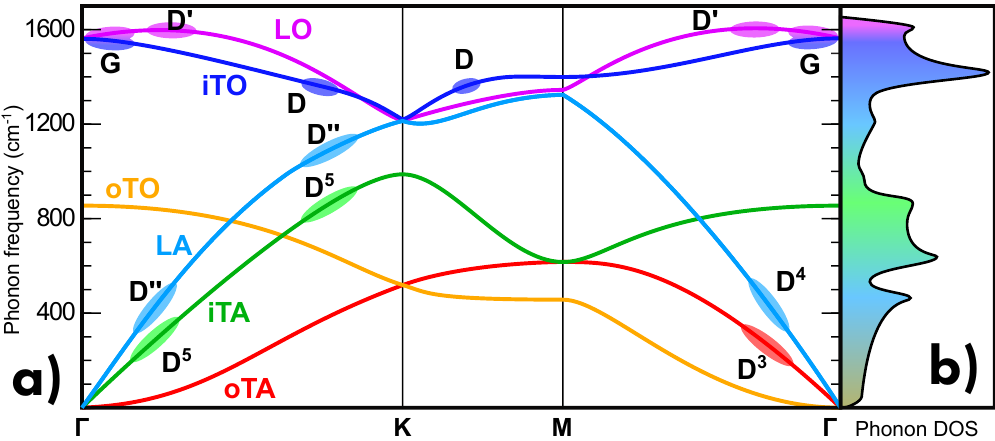
Figure 14. ( a ) Phonon dispersion relation for graphene along the direction connecting the high-symmetry points Γ , K , and M . The phonon branches are labeled in accordance with their type of atomic displacement. Various Raman contribution is indicated, as well as the corresponding range of phonon wavevector. ( b ) Phonon density of states (DOS) of graphene. The contribution of Raman mode at different phonon frequency is indicated by color. Adapted with permission from Refs. [56,57]. Copyright (2011) American Physical Society and (2018)